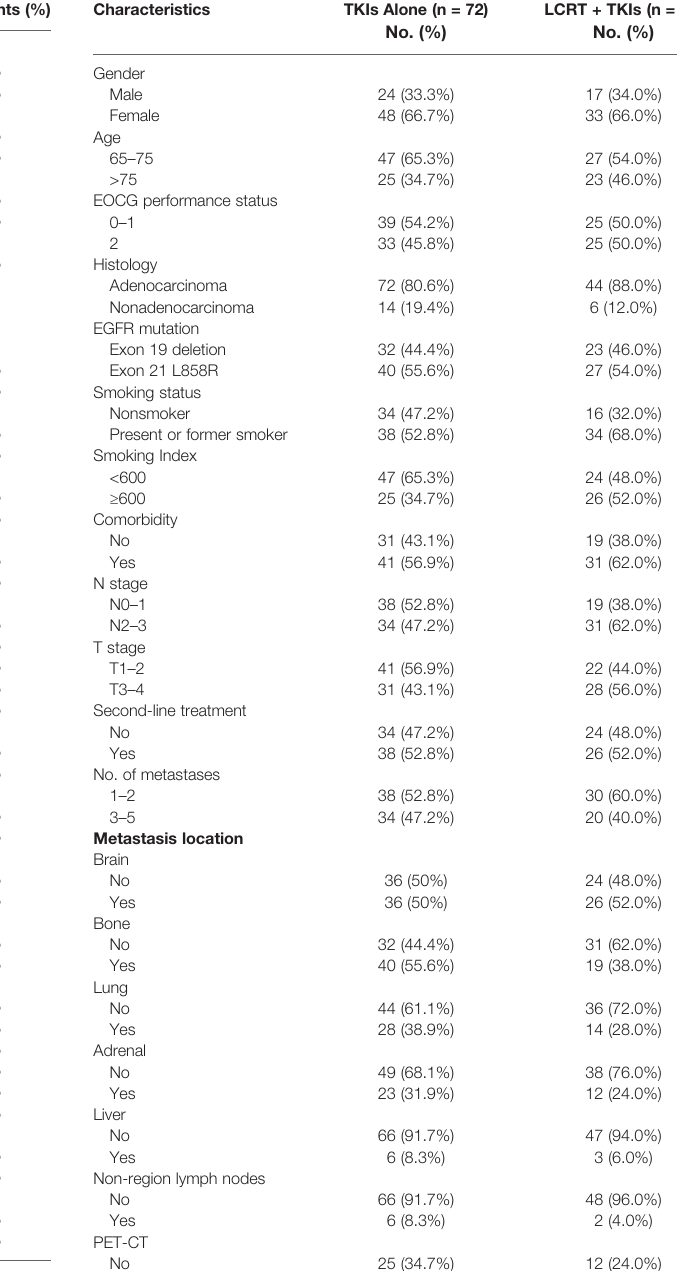
NSCLC,non-smallcelllungcancer;SmokingIndex,numberofcigarettessmokedperday×years ofsmoking;ECOGPS,EasternCooperativeOncologyGroupPerformanceStatus;TKIs,Tyrosine Kinase Inhibitors; EGFR, Epidermal Growth Factor Receptor; PET-CT, Positron Emission Tomography Computed Tomography; LCRT, Local Consolidative Radiation